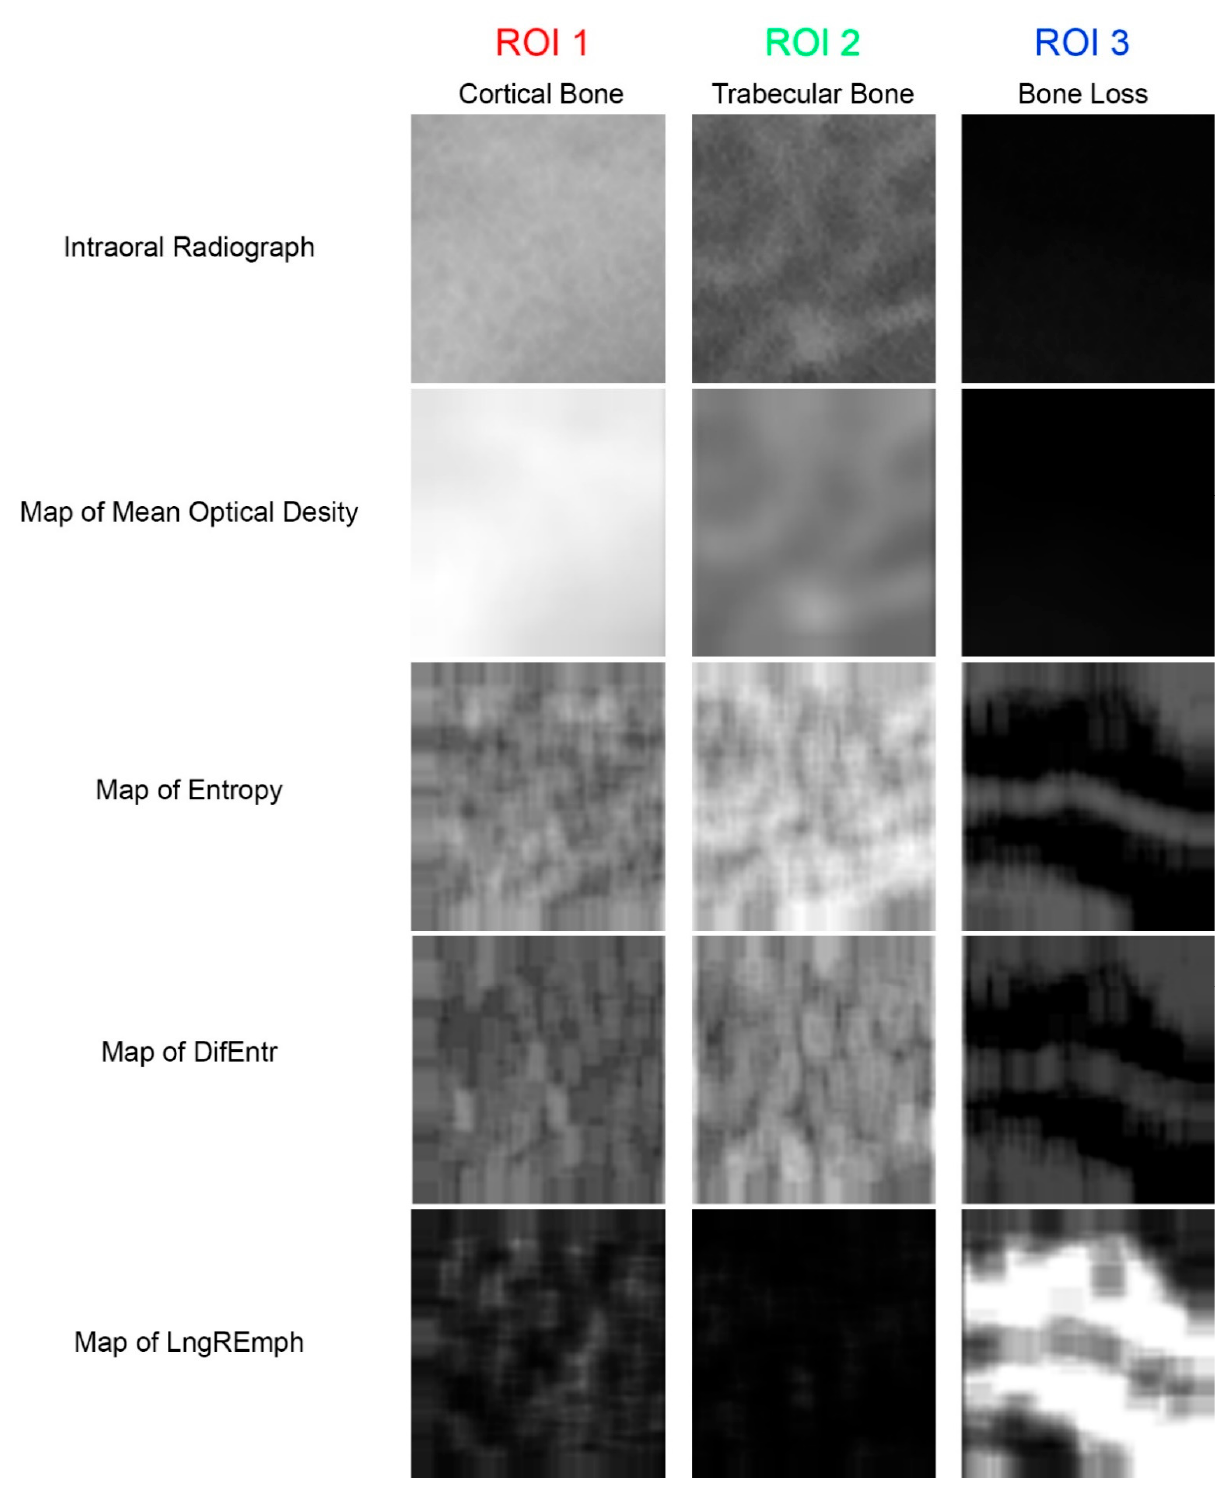
Figure 2. The source material and the primary texture features extracted from it. The meanings of the ROIs are the same as in Figure 1. Maps of the local intensity of the studied features are below the original radiographs. The map is created from square boxes of nine pixels. In the maps of features, lighter areas indicate higher local intensity of the feature, while darker areas indicate lower intensity of the feature.